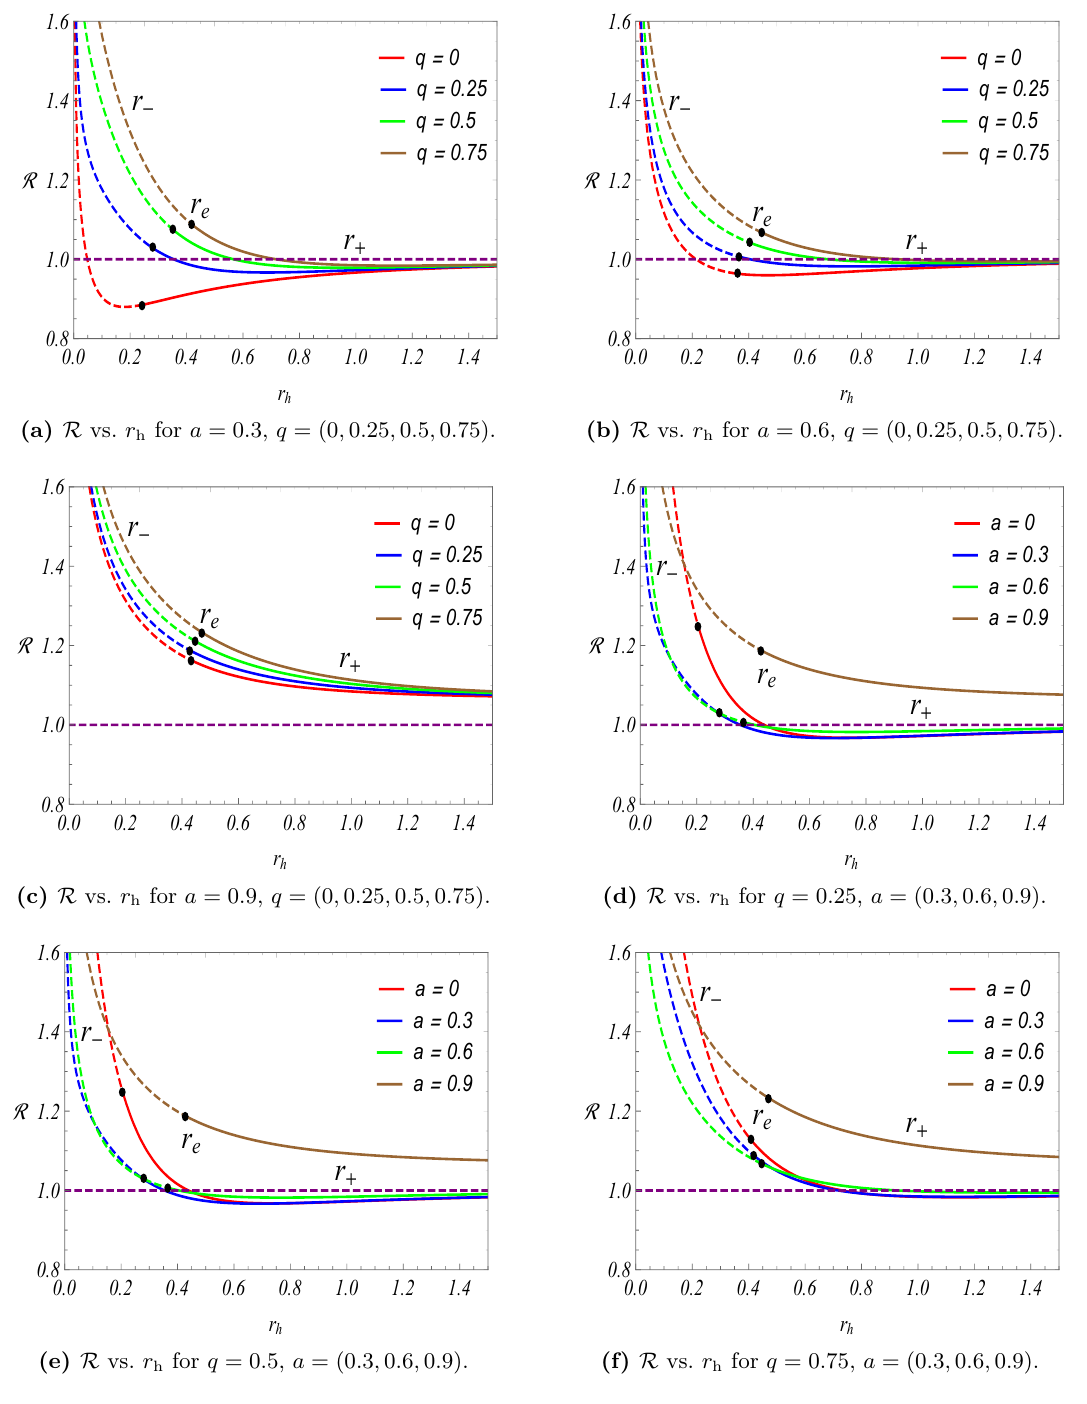
Figure 2 . The isoperimetric ratio R vs. horizon radius r h with different numerical values of the rotation parameter a and charge parameter q ( l = 1 ). Solid/dashed lines correspond to outer/inner horizons, while black dots mark out the extremal horizons. Dashed horizontal purple line corre- sponds to R = 1